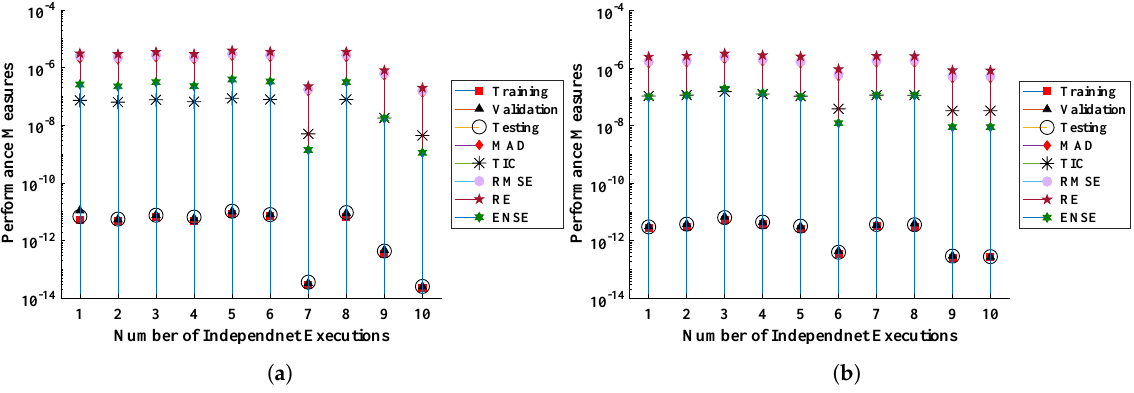
Figure 13. Detailed study of each execution of the proposed technique for the behavioral study of different performance indicators for calculating the solutions for ( a ) velocity and ( b ) acceleration of the fluid with isoflux boundary